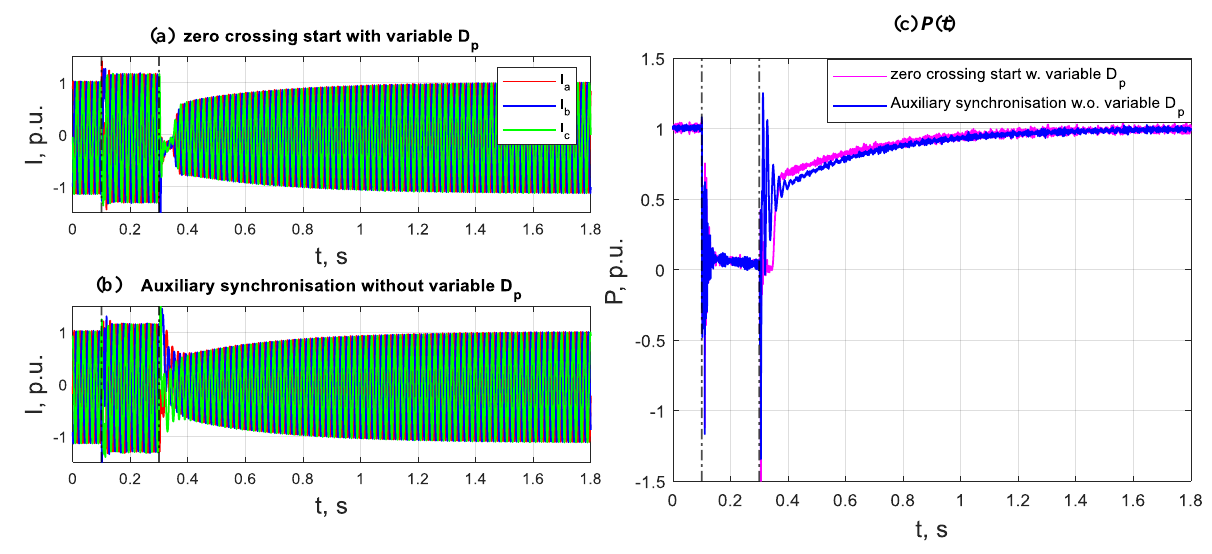
Figure 19. Zero-crossing start with and without variable droop factor 𝐷 p . The usage of a variable 𝐷 p (magenta curve) leads to a faster power recovery after the fault clearing.